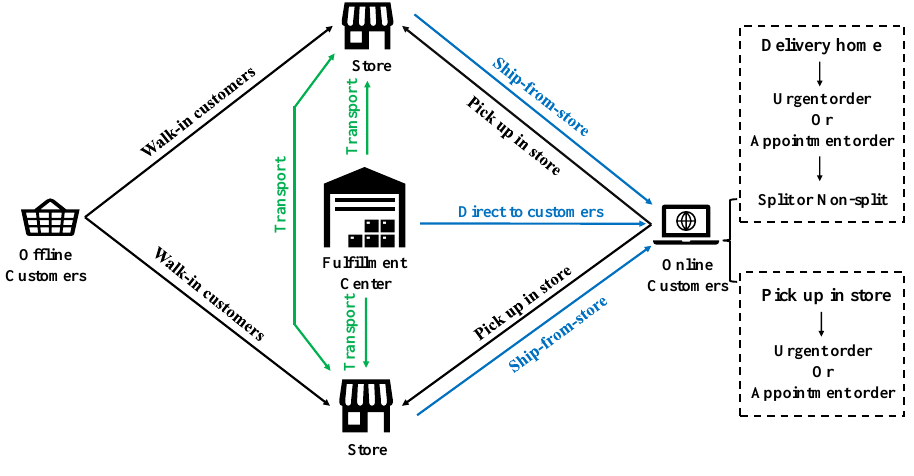
Figure 1. Options of order